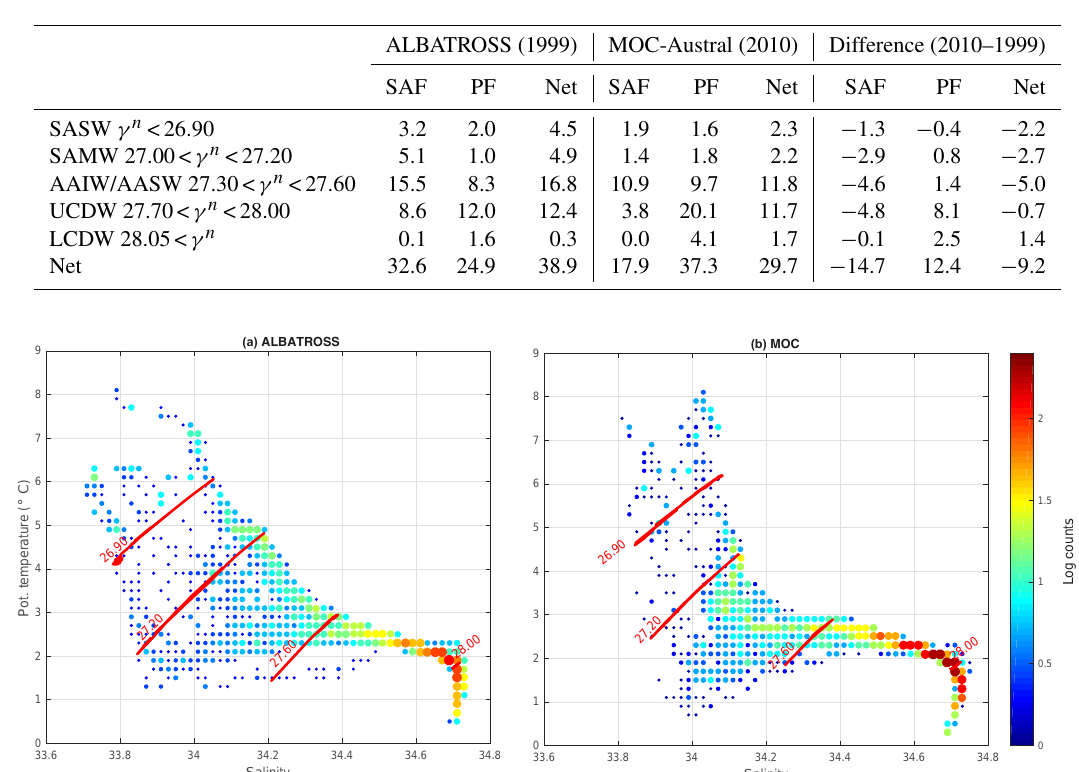
Table 1. SAF, PF and net geostrophic mass transport (Sv) per cruise and water mass. The last row shows the net transport, while the last column indicates the transport difference between cruises.